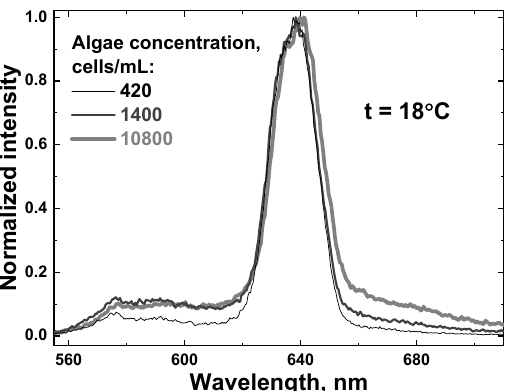
Figure 10. Raw LiDAR spectra of water samples with different algae concentrations: 420 cells/mL (thin black line), 1400 cells/mL (dark gray line) and 10,800 cells/mL (thick light gray line). All the spectra were recorded at the sample temperature of 18 °C.